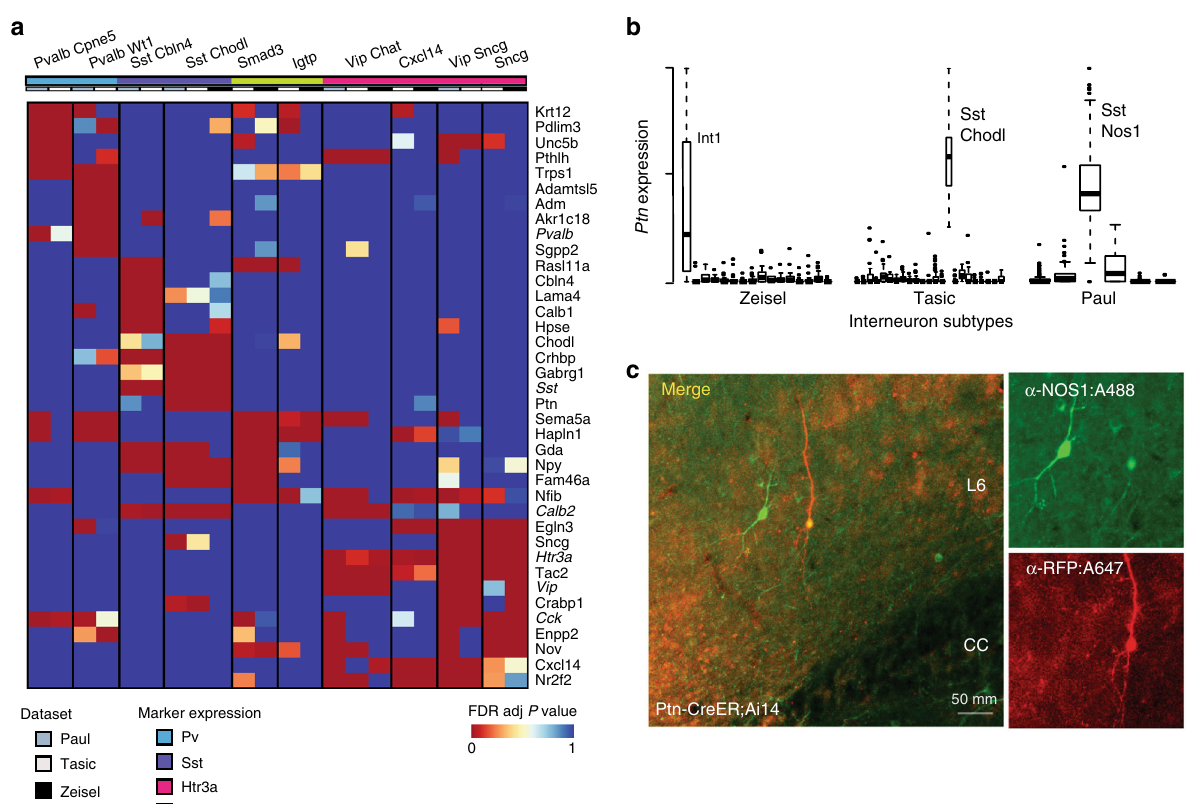
Fig. 5 Replicated subtypes show consistent differential expression. a (Top) Heatmap of FDR-adjusted P values of top differentially expressed genes among replicated interneuron subtypes (NB only 10 subtypes are shown as no differentially expressed genes were found for the Ndnf Car4 subtype). Subtype names are listed at the top of the columns and are labeled as in Tasic et al 20 . Many genes are commonly differentially expressed among multiple subtypes, but combinatorial patterns distinguish them. b Standardized Ptn expression is plotted across the three experiments, where each box represents an interneuron subtype. Boxes bound the quartiles, middle lines represent the median, whiskers extend to 1.5 times the interquartile range, and values outside of this range are shown as individual points. High, but variable expression is observed across the three Sst Chodl types. c Confocal images of co- immunostaining for Ptn -CreER;Ai14 with RFP and Nos1 antibodies in adult mouse cortex. Ptn -CreER;Ai14 expression was induced with low-dose tamoxifen postnatally. Clear co-labeling is observed in a deep layer (L6) long projecting